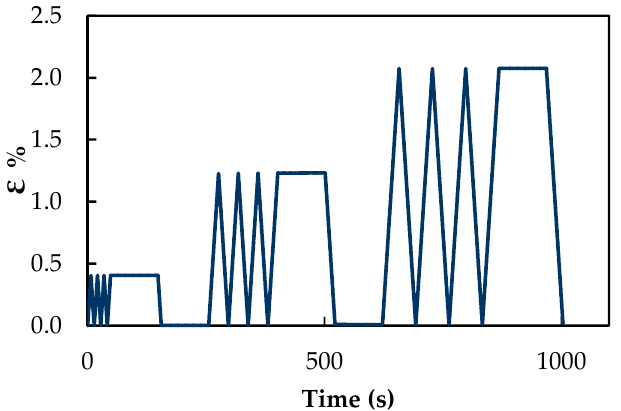
Figure 3. Applied strain as a function of time during one loading/unloading cycle.